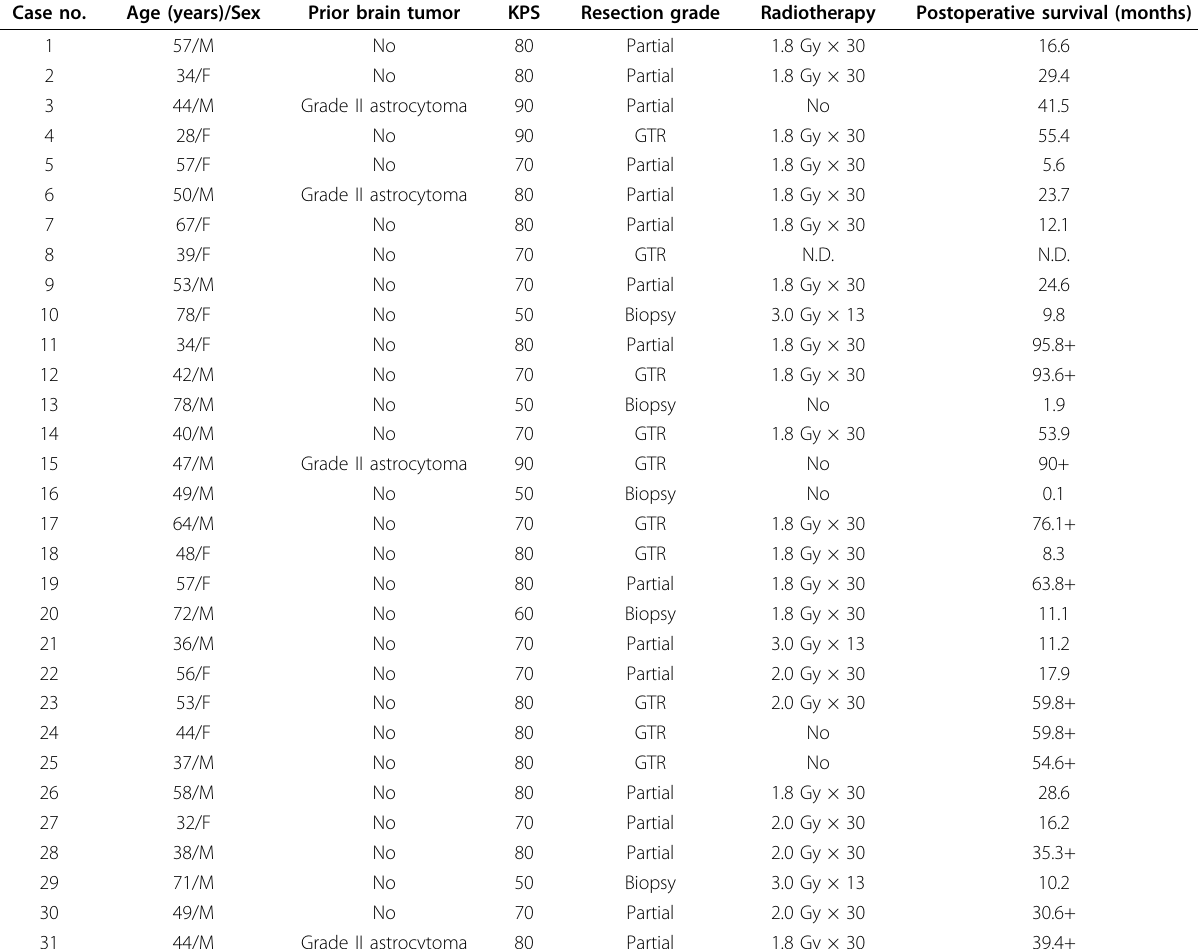
Table 2 Patient characteristics Case